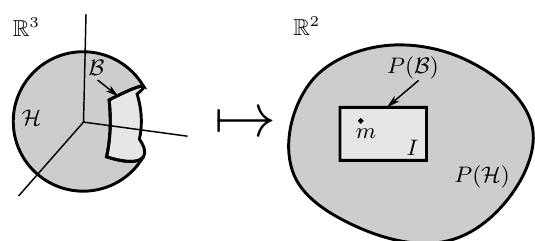
Figure 1. The projection of the hidden part H of the unit sphere by a continuous function would necessarily contain any point m of the image domain I .